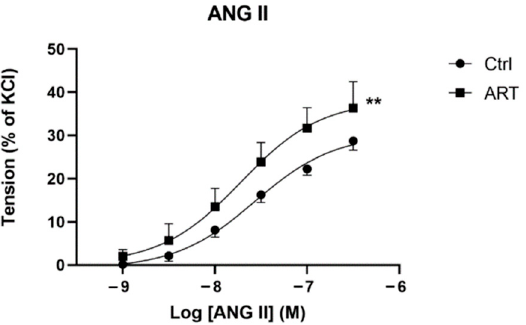
Figure 1. Vasoconstrictor response of aortic rings to ANG II in presence of L-NNA, measured with wire myography and expressed in % of maximal KCl contraction ( n ≥ 6/group). Values are the Means ± SEM. Data were analyzed by two-way ANOVA. ** p < 0.01, ART vs. Ctrl.